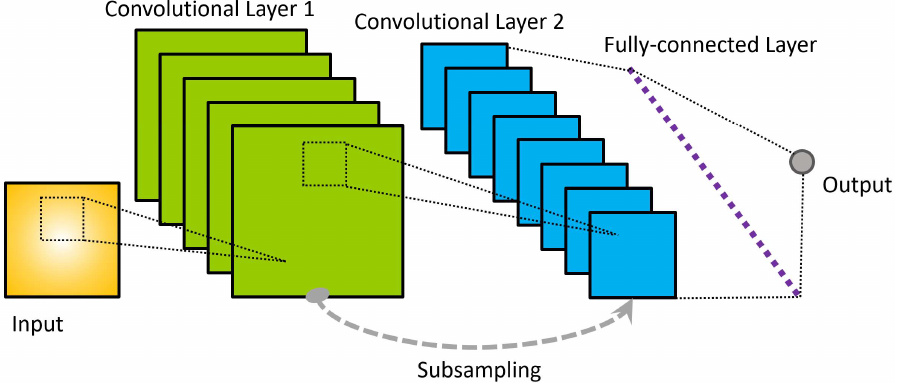
Figure 3. The typical structure of a CNN . In this diagram, the yellow square ( left ) and the grey circle ( right ) represent the input data and the output data, respectively. Besides, the green and blue squares represent the first and second convolutional layers, and there is a pooling step (grey dashed arrow) in between for subsampling. Before the output, a fully-connected layer (purple dotted line) is utilised at the end of the CNN.